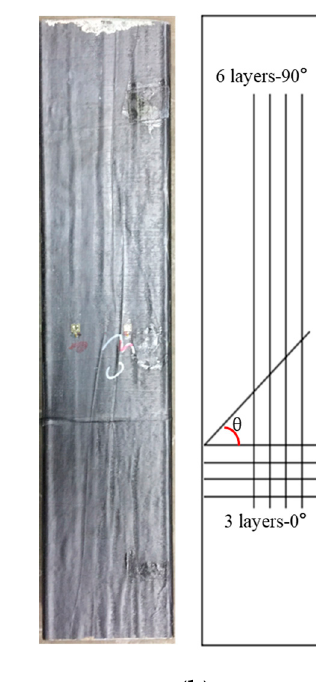
( d ) Figure 3. ( a ) Cross-section of a specimen. ( b ) The layup of CFRP. ( c ) Setup of the four-point bend- ing test. ( d ) Compression test. 2.1.2. Loading Facility and Loading Program Compression tests of the FWPs were carried out using a static loading method, and the load was applied by a 200 t universal testing machine, as shown in Figure 3d. Four-point bending tests were carried out in a force-controlled fashion. The tested specimen beam was simply supported (see Figure 3c). The jack force P was imposed on the specimen via a distribution beam. The jack force was increased by 0.05 kN/s up to the load-bearing capacity of the specimens. 2.1.3. Measurement Program In the bending tests, the experimental measurements concerned the strain and the deflection of the specimens. As for measuring the strains, two gauges were located each on the top and the bottom surface of the specimens. Three gauges were evenly located on the side surface, as shown in Figure 4.